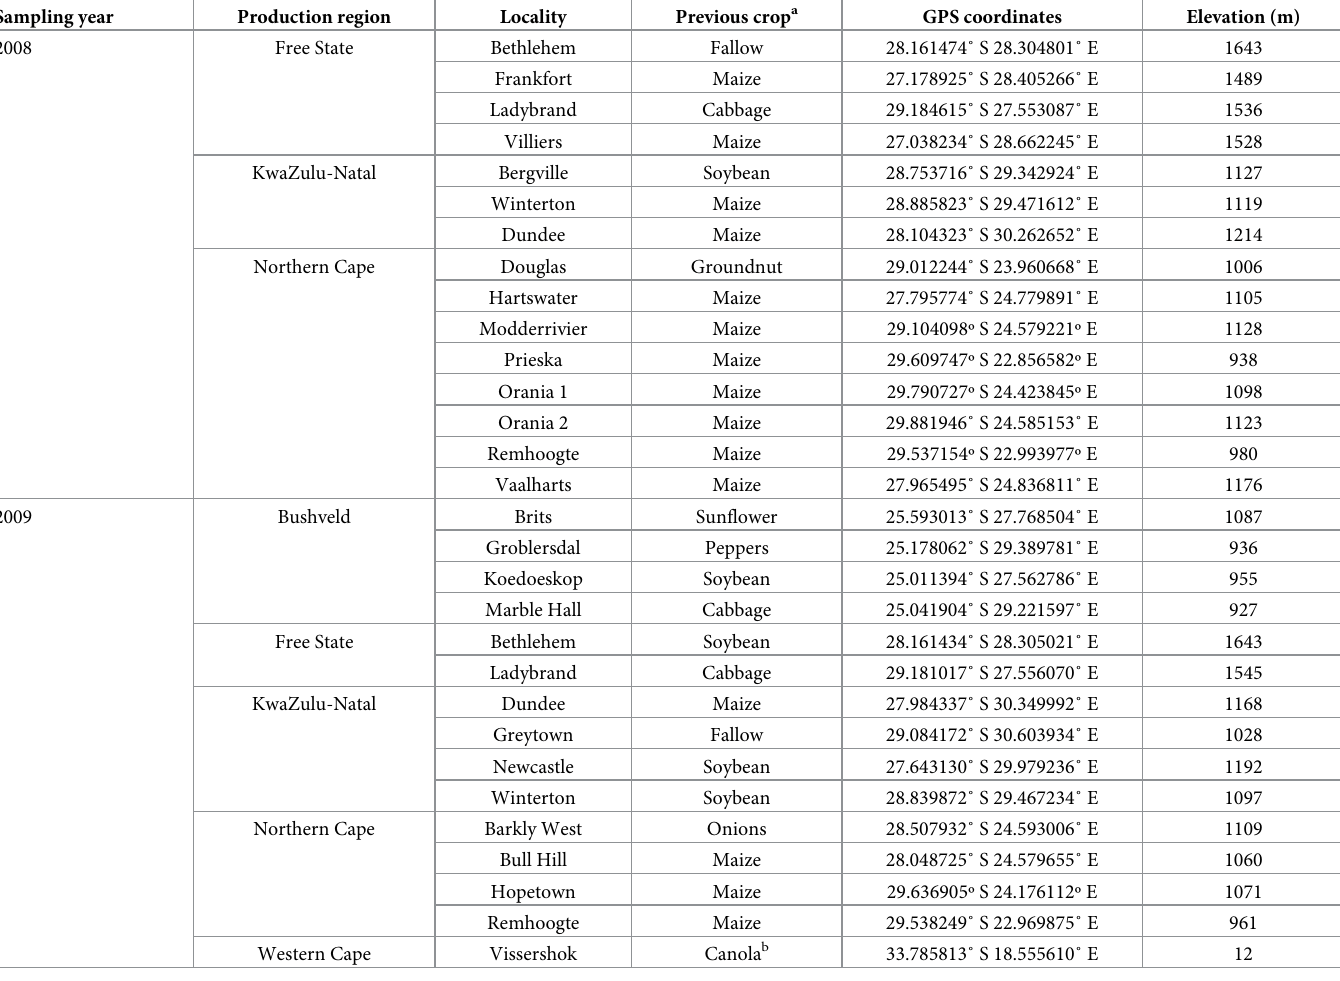
Table 1. Production region, cultivar, crop history and geographical information of localities where wheat heads with Fusarium head blight symptoms were sampled. Sampling